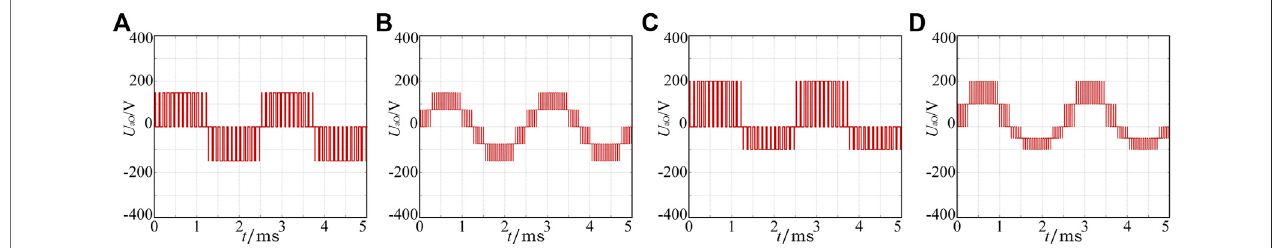
FIGURE 9 | Simulation results of phase voltage for various operation modes and conditions: (A) parallel, (B) interleaved, (C) unbalanced parallel, (D) unbalanced interleaved.